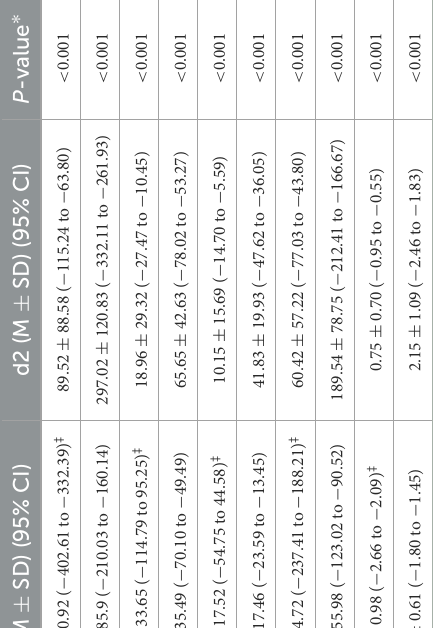
TABLE 3 ANOVA test for two-stage crossover